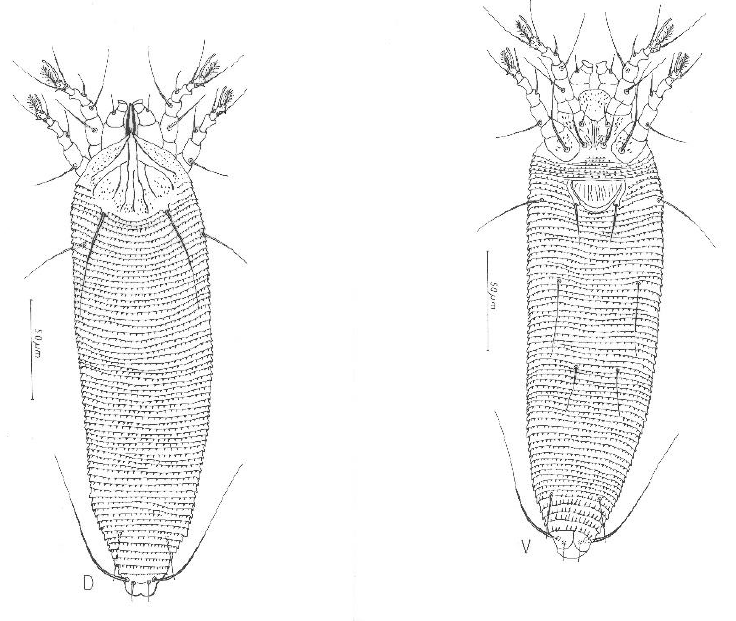
Figure 2. Schematic drawings of female Aculodes marcelli sp. nov. : D=dorsal mite; V=ventral mite. MALE (n = 2). Body wormlike, 197–200, 53–54 wide, whitish in color. Gnathosoma 17 Type host plant. Anisantha tectorum (L.) Nevski (Poaceae), cheatgrass. Type locality. Starosel, Bulgaria 42.485°; 24.5522°, 396 m elev. Type material. Female holotype (slides # 862/1) and paratypes 42 females, 4 males; 3 May 2018, collected by Brian Rector.